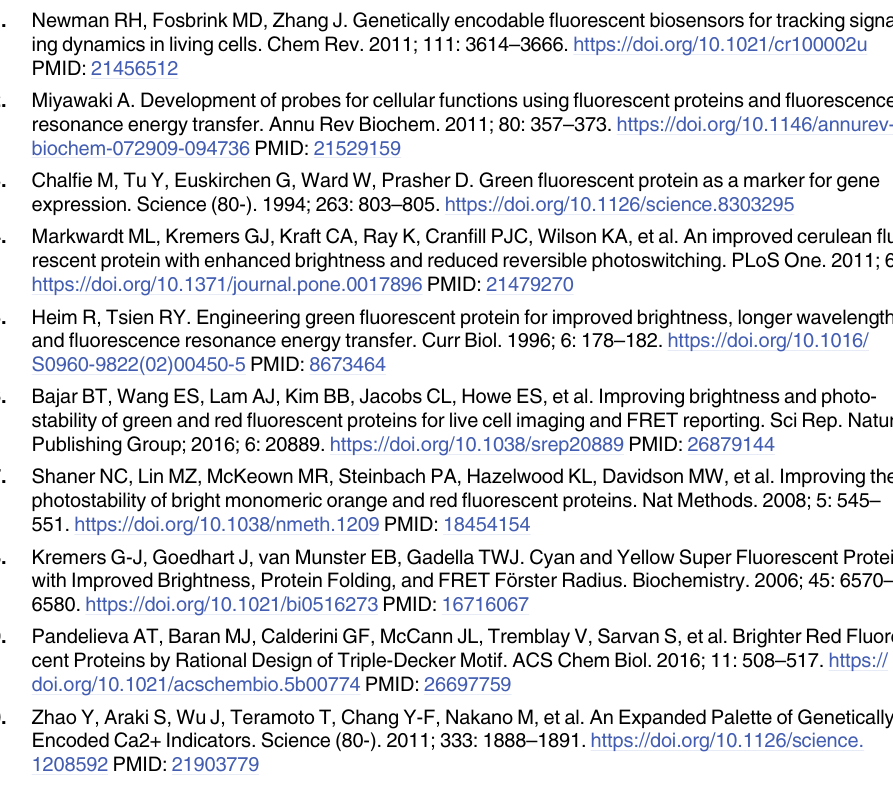
are shown. Those residues that are the same as mCardinal are highlighted in blue, and those residues that are in mScarlet are highlighted in Red. Residues that are not found in mCardinal or mScarlet are not highlighted (white